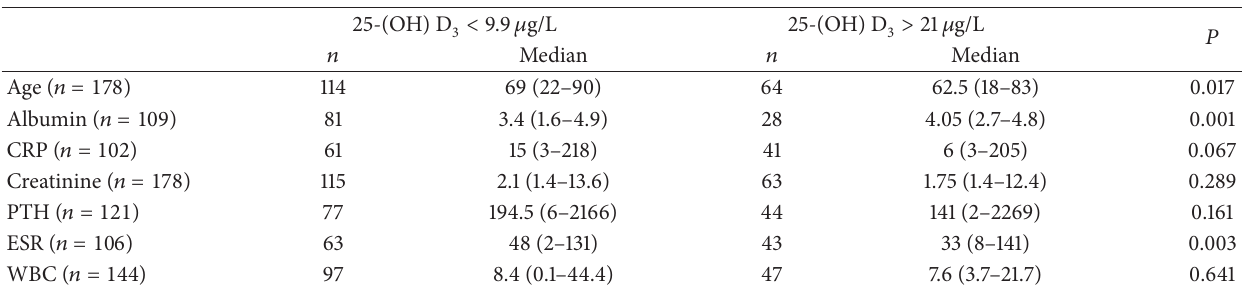
CRP: C-reactive protein; PTH: parathormone; ESR: erythrocyte sedimentation rate; WBC: white blood cells; SD: standard deviation; Min: minimum; Max: maximum.